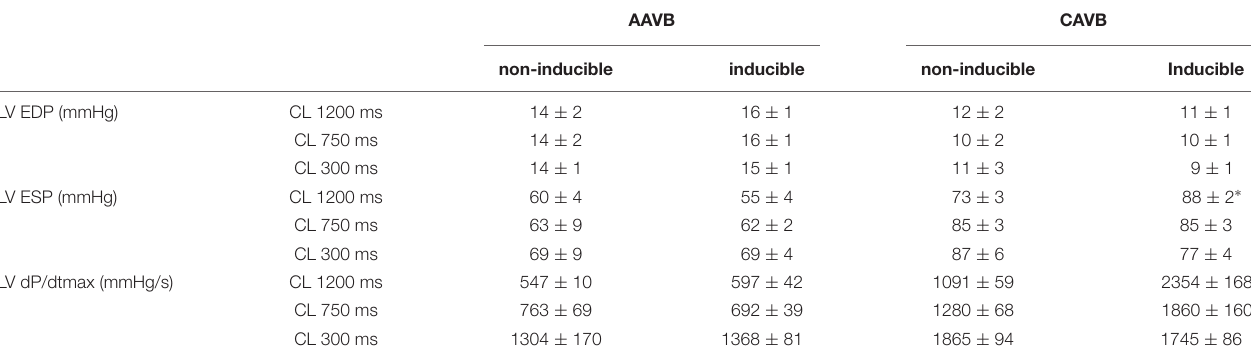
TABLE 2 | Hemodynamic parameters of non-inducible and inducible dogs.